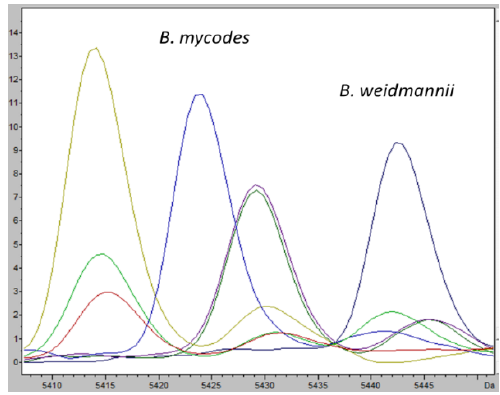
Figure 5. Average mass spectra of characteristic ion peaks among various Bacillus species understudy. Intensities of characteristic ion peaks ( m/z 5424 for B. mycoides in light blue, m/z 5443 for B. weidmannii in dark blue) are expressed in arbitrary intensity units.